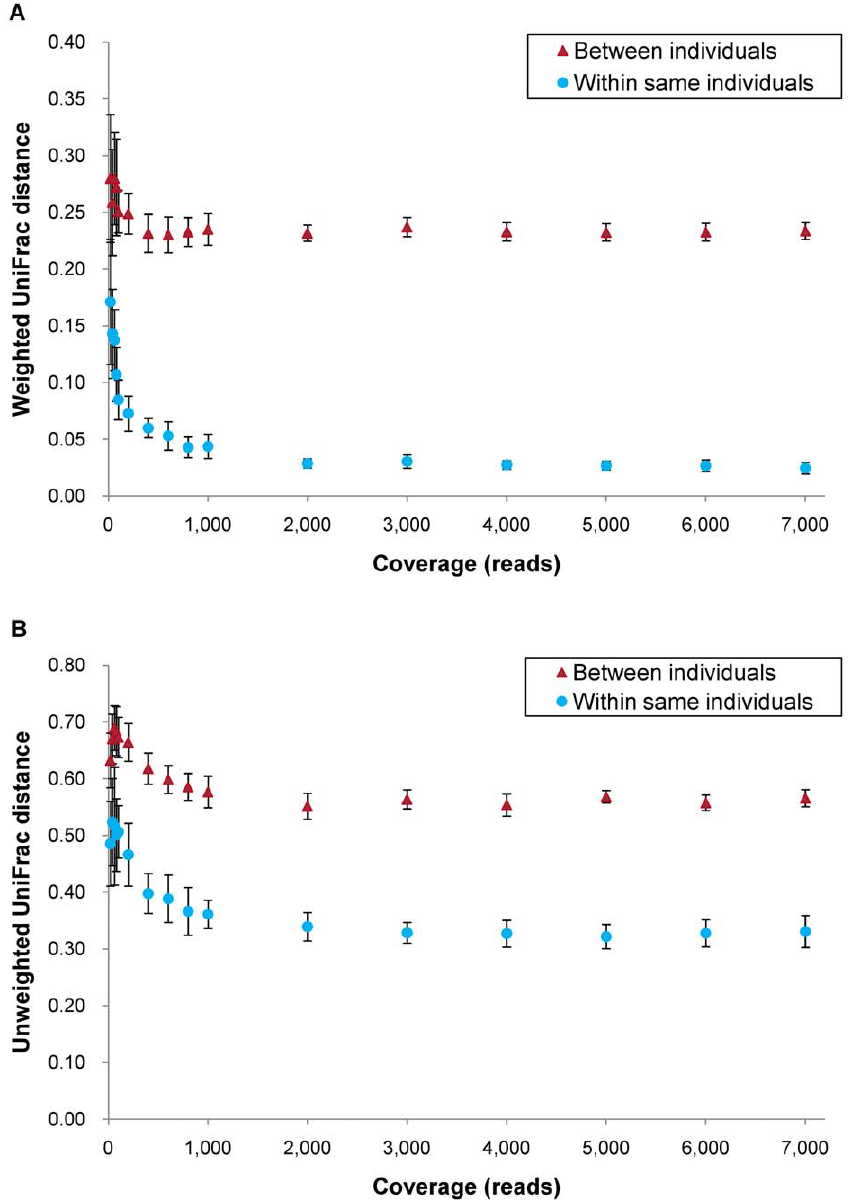
Figure 1. Association between coverage and UniFrac distances at different coverage. (A) Weighted and (B) unweighted UniFrac distances. For ‘Between individuals’ each data point includes 36 distances calculated from 6 samples of individual B and 6 samples of individual C. For ‘Within same individual’ each data point includes 18 distances (9 within sample B and 9 within sample C). Mean 6 SD.